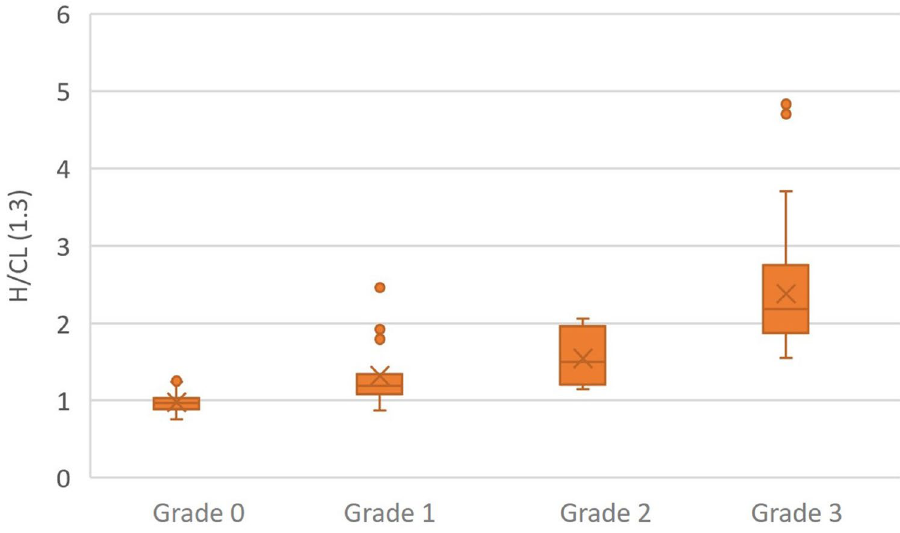
Figure 3. Ranges of values and estimated median uptake for each grade.